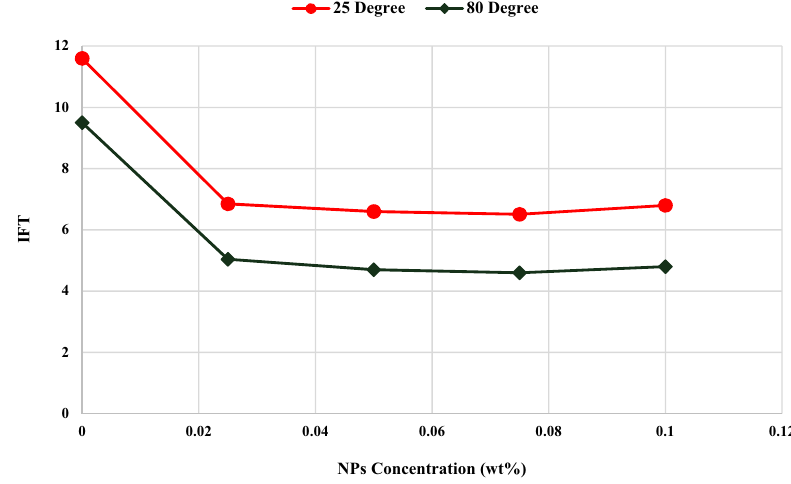
Figure 8: IFT of oil/aqueous phases at di ff erent temperatures as a function of the concentration of NPs.